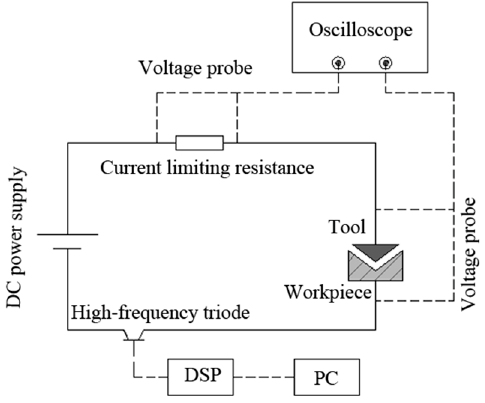
Figure 1. Schematic diagram of a single-pulse discharge system. DSP: digital signal processor.